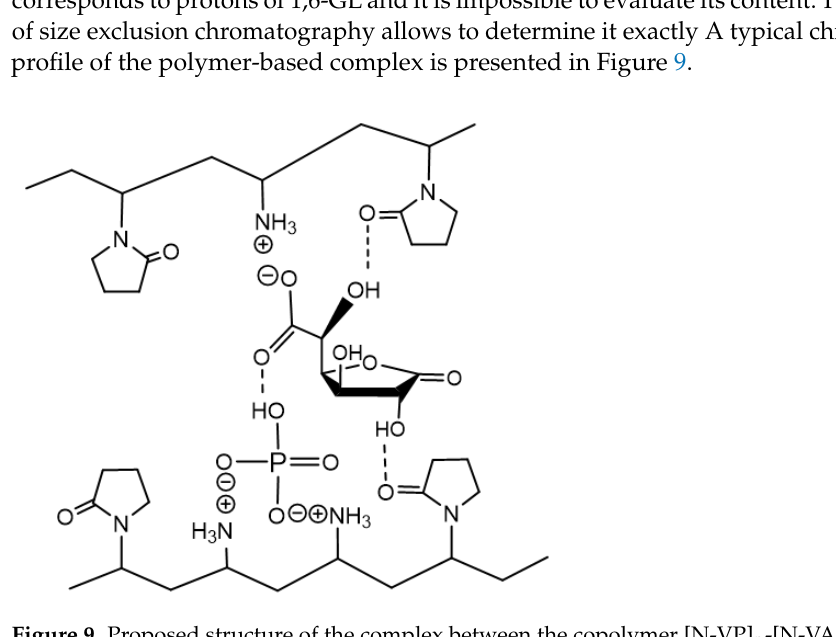
Figure 9. Proposed structure of the complex between the copolymer [N-VP] n -[N-VA] m and [1,4- and 6,3-GL] lactones.